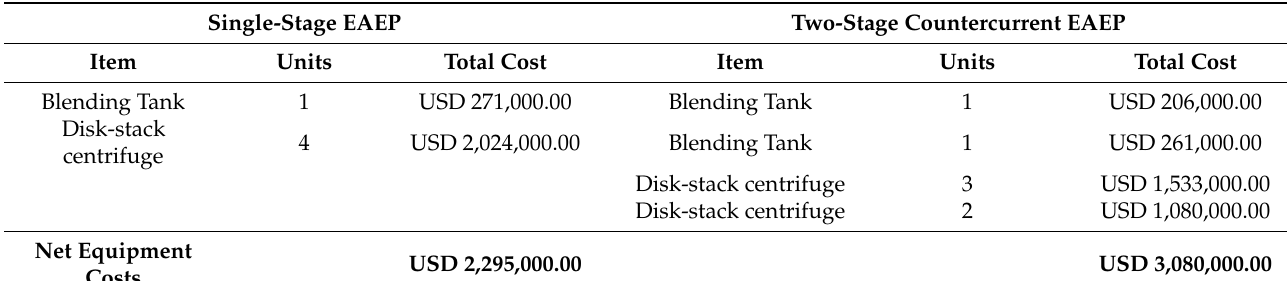
Table 3. Equipment costs of single-stage and two-stage countercurrent